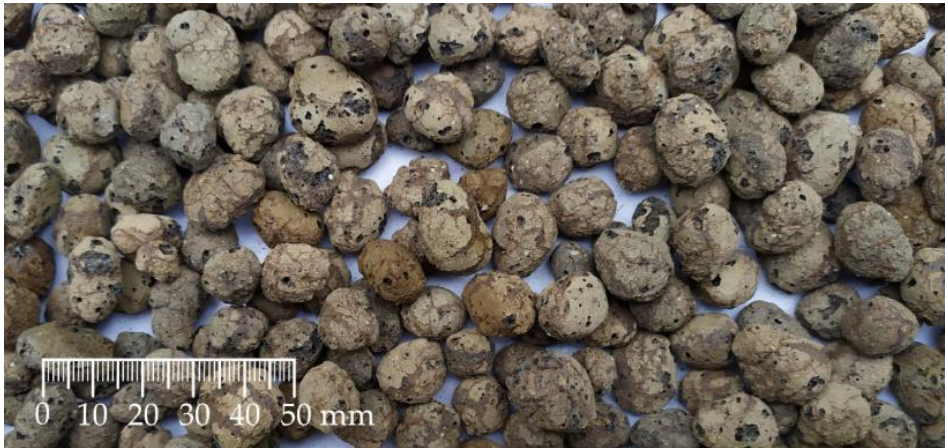
Figure 3. Certyd: a sintered ceramic lightweight aggregate. All beams were cast from the same batch of ready-mixed concrete. At the same time, standard samples were taken from the batch to test the strength properties of concrete; specifically, cylindrical samples were taken to determine the compressive strength f c , f lc and modulus of elasticity E c ,E lc, , as well as the sigma-epsilon characteristic. Compressive strength f c,cube , f lc,cube and splitting tensile strength f ct,sp , f lct,sp were determined on cubic samples. The age of the concrete during the tests was in the range of 152 ÷ 164 days. The LWAC and NWC properties determined on the test day are shown in Table